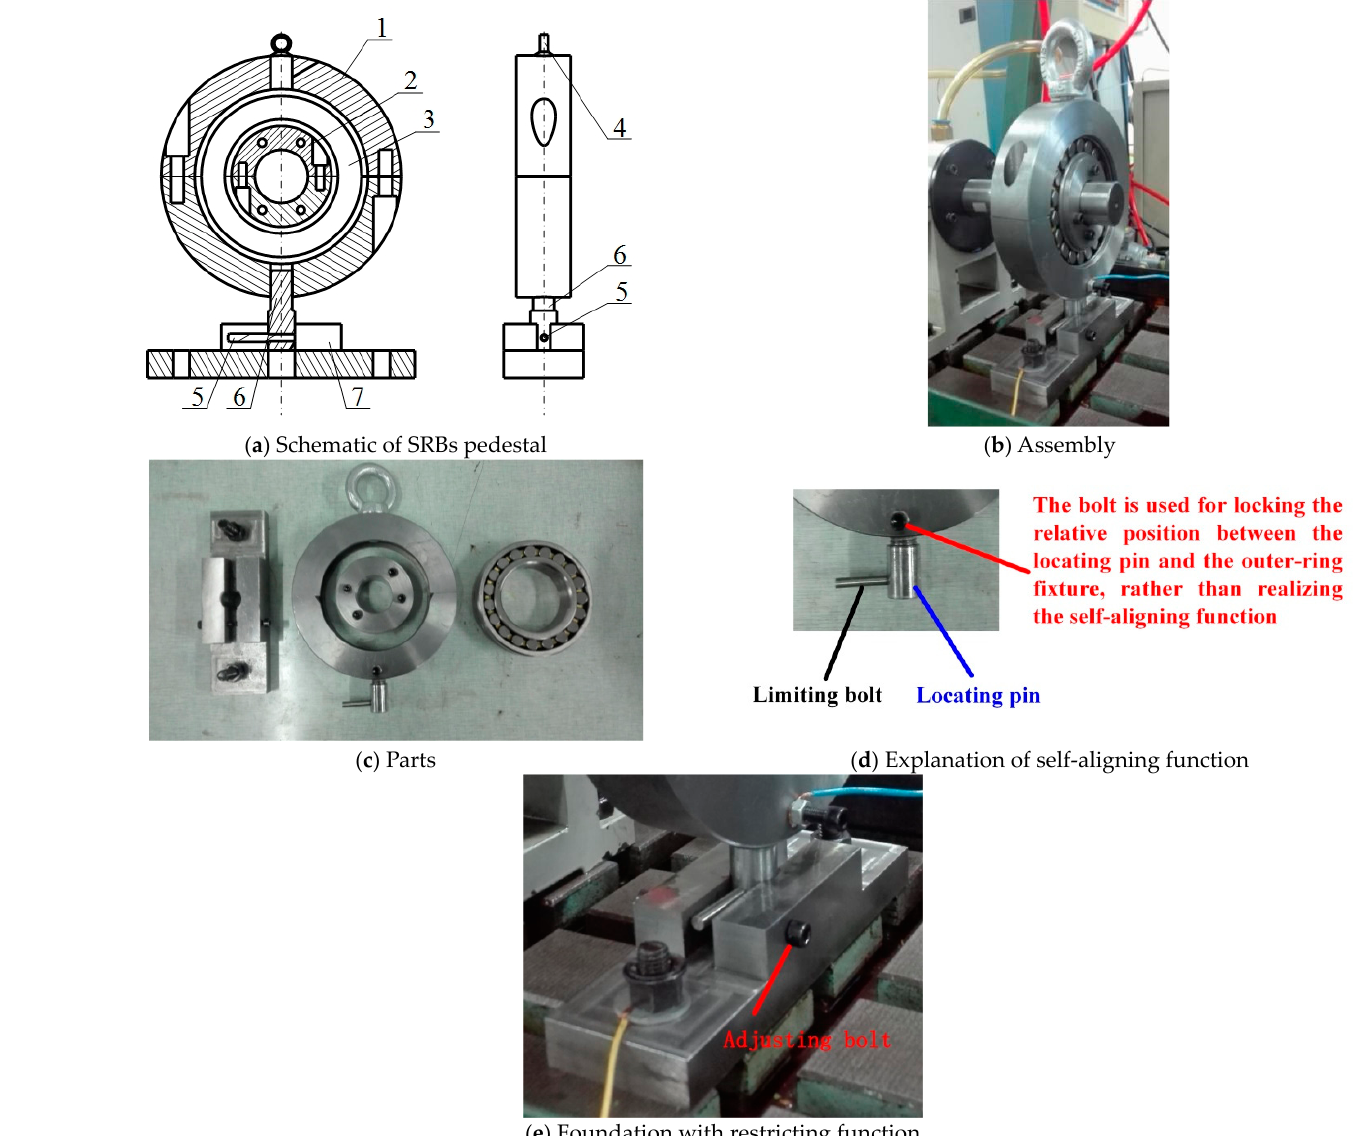
Figure 8. SRBs pedestal with self-aligning function. 1 outer-ring fixture; 2 inner-ring fixture; 3 SRB under test; 4 loading ring; 5 limiting bolt; 6 locating pin; 7 foundation; 8 adjusting bolt